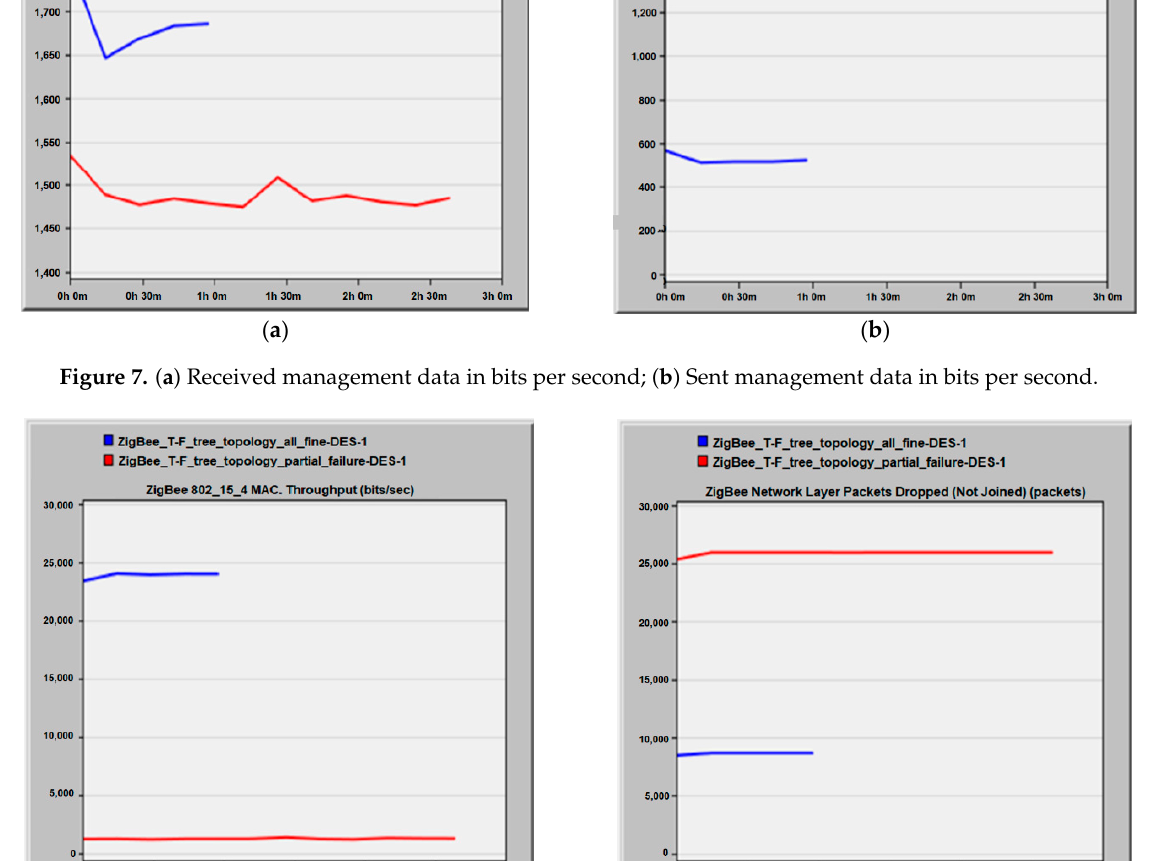
Figure 8. ( a ) The network throughput in bits per second; ( b ) Number of packets rejected during transmission.